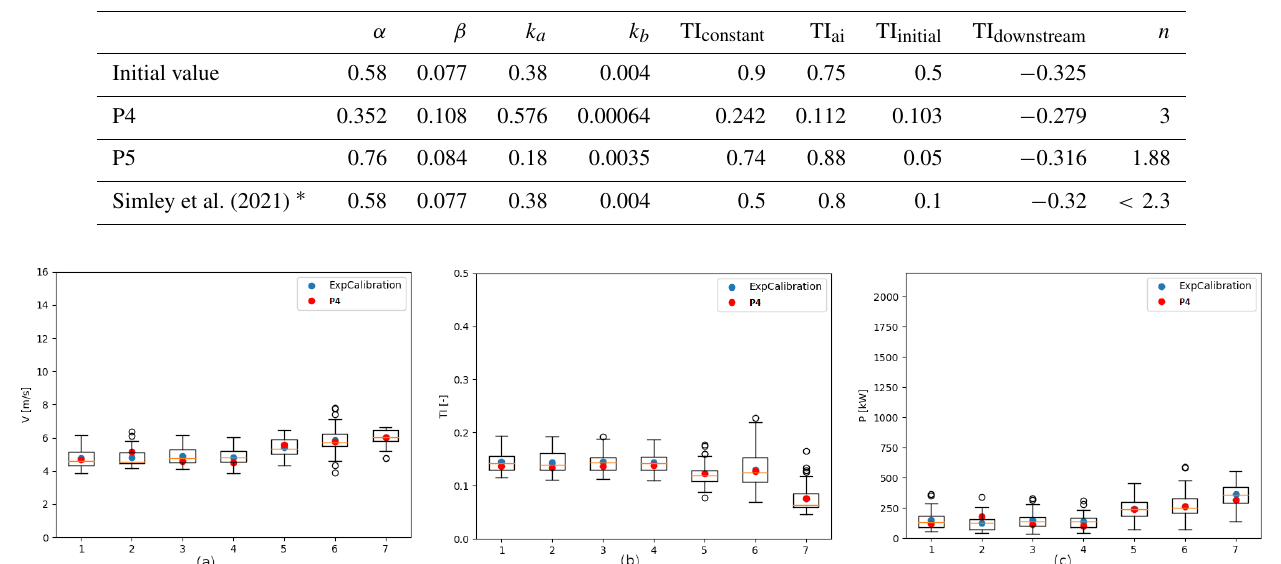
Figure 4. P4: the y axes show (a) velocity (ms − 1 ), (b) turbulence intensity (TI, –), and (c) power ( P , kW). Comparison per SMV wind tur- bine (turbine numbering SMV1–SMV7 on the x axis) between experimental data (boxplot), average values used for experimental calibration (ExpCalibration, blue circles), and simulation with calibrated parameters (P4, red circles). Bin direction = 185 ◦ ; bin wind speed = 6ms − 1 . Empty black circles represent